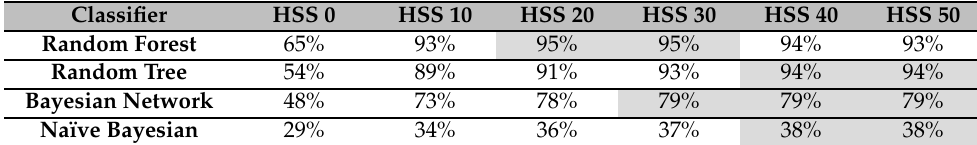
Table 7. Classifier results for 2-fold cross-validation (RF) for varying historical set sizes (HSS).